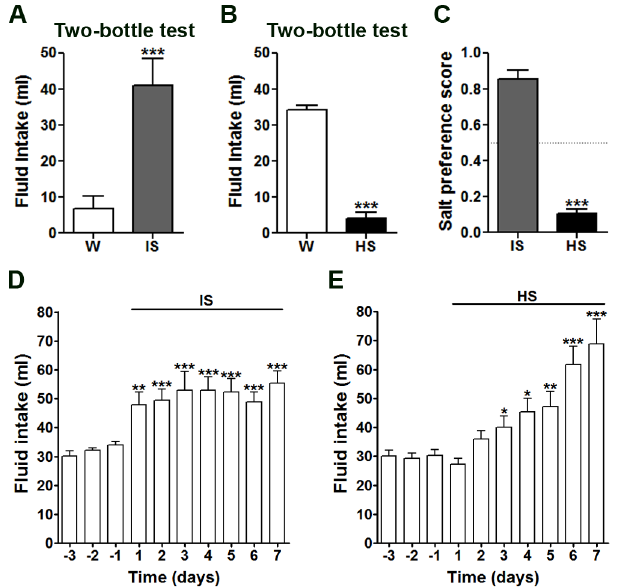
Figure 1. Mean fluid intake in two-bottle and one-bottle salt intake tests in naı¨ve rats. Intakes of IS (A) and HS (B) compared to water in 24 h two-bottle choice tests in naı¨ve rats. C, mean preference scores for IS and HS solutions in 24 h two-bottle salt choice tests with water. One-bottle intake tests with IS (D) and HS (E) in naı¨ve rats. Error bars + SEM, n=6–10 animals per group. *p , 0.05, **p , 0.01, ***p , 0.001. HS, hypertonic saline; IS, isotonic saline; W, water.